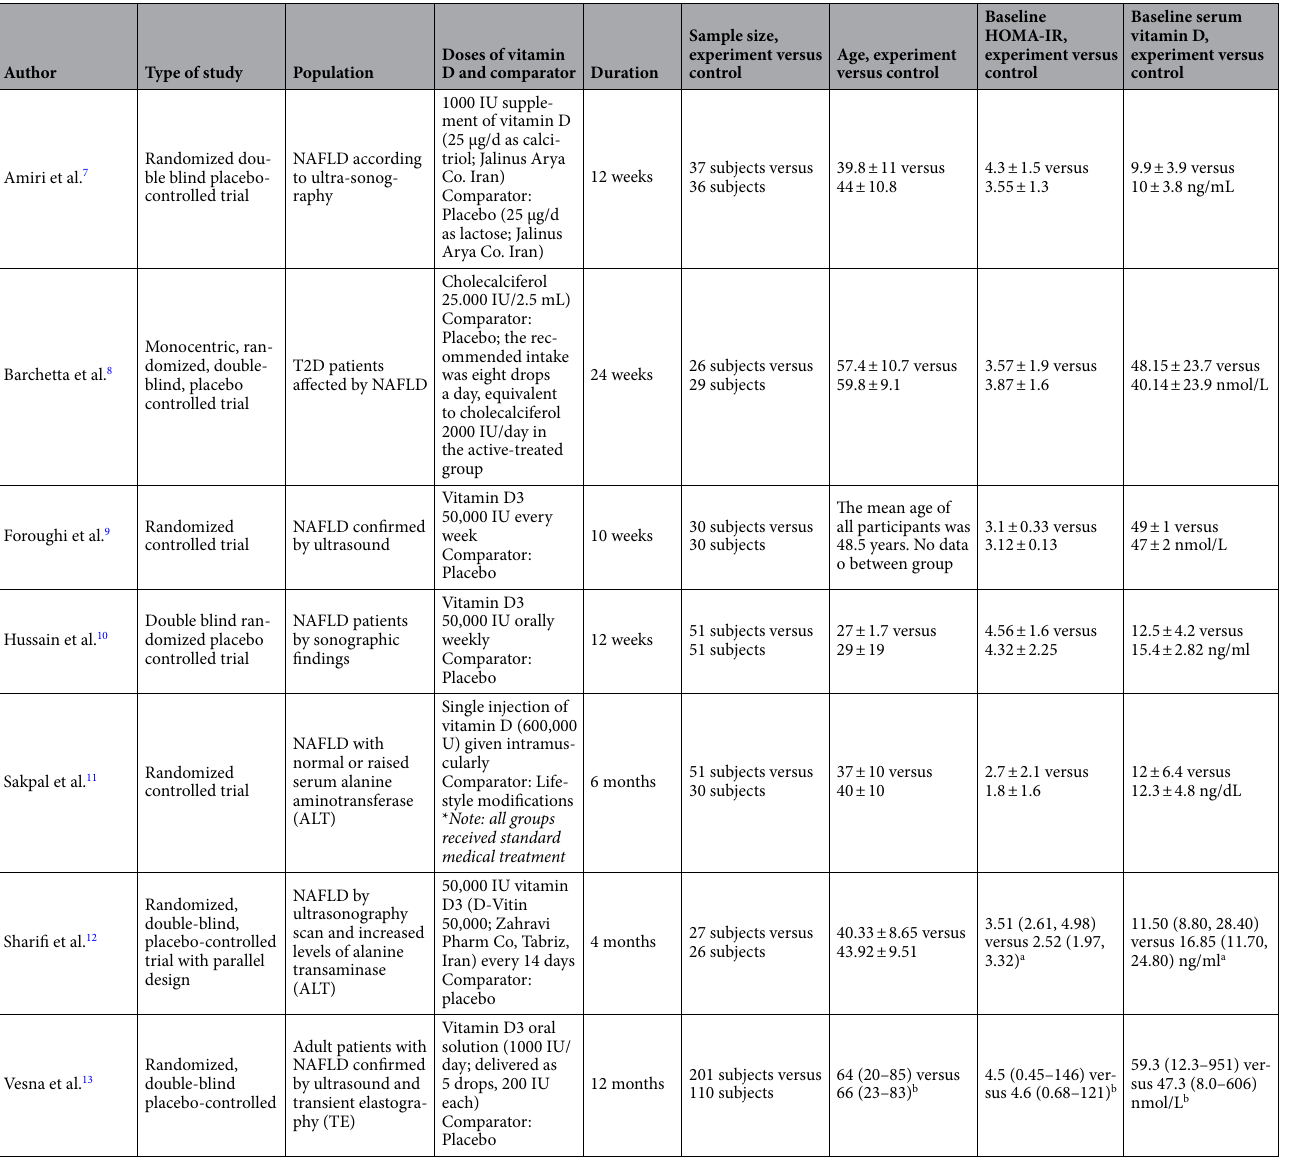
Table 1. Summary of findings and studies characteristics. HOMA-IR: Homeostatic model assessment for insulin resistance. All data presented as mean ± SD, unless indicated otherwise. a Data presented as median (Q1, Q3). b Data presented as median